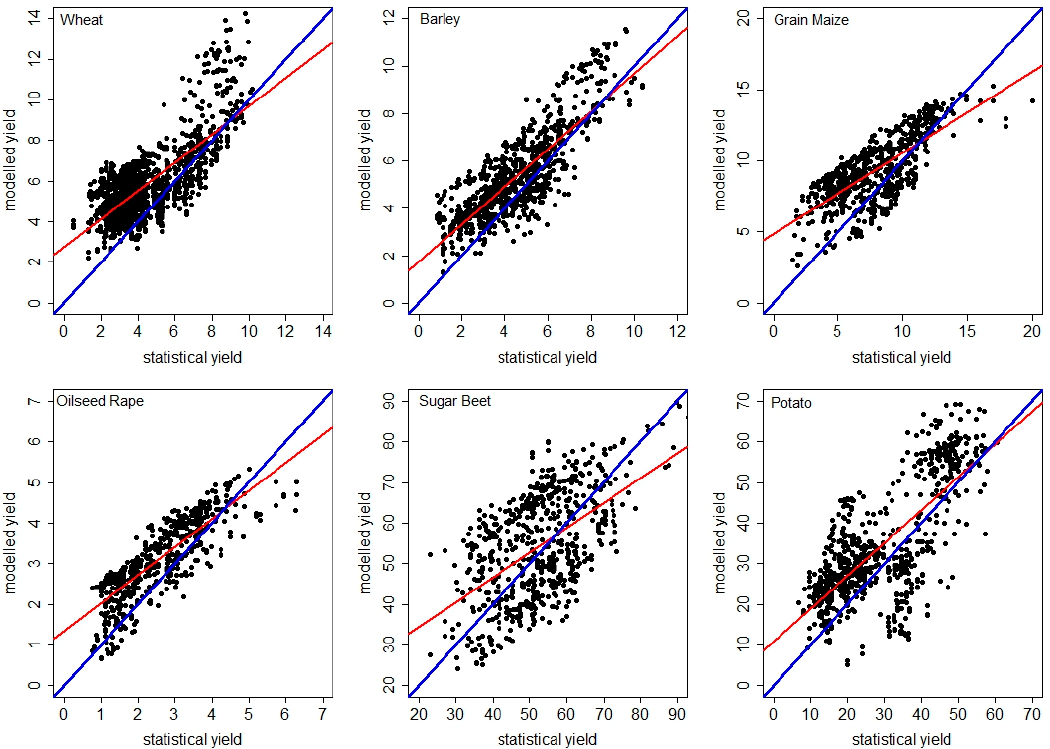
Figure 8. Comparison of modelled and statistical yields (in Mg ∙ ha − 1 ) and expressed in fresh weight for major arable crops across the European regions for the period 1992–2012, including the identity line (blue) and a linear regression of modelled on statistical yield (red). Table 2. Modelled and statistical yields (in Mg ∙ ha − 1 ) and harvest index (HI in %) for the major arable crops in Europe for the period 1992–2012. For crop abbreviations see Figure 3.